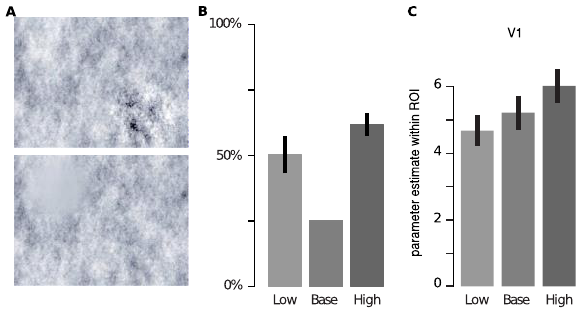
Figure 4. (A) Examples of pink-noise stimuli with increased (top) and decreased (bottom) contrast modifications. (B) Fraction of fixations made to modified quadrant for all three conditions. The salience of a quadrant is increased by decreased luminance contrast and by increased luminance contrast. (C) Mean BOLD activation in V1 in the